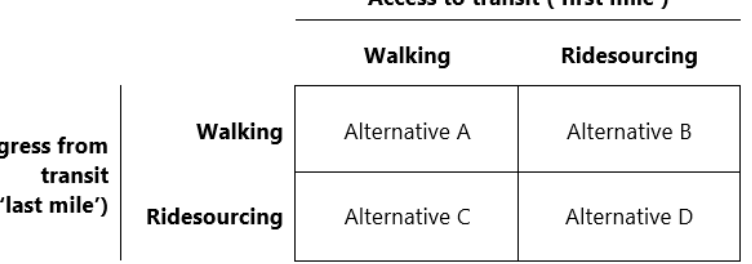
Figure 4. Alternative access/egress combinations for which travel times are